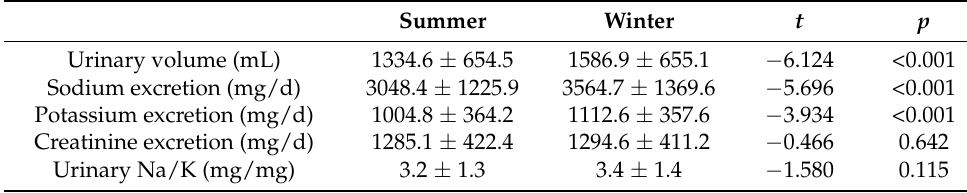
Table 2. Results of 24-h urine measurement of college students by season.